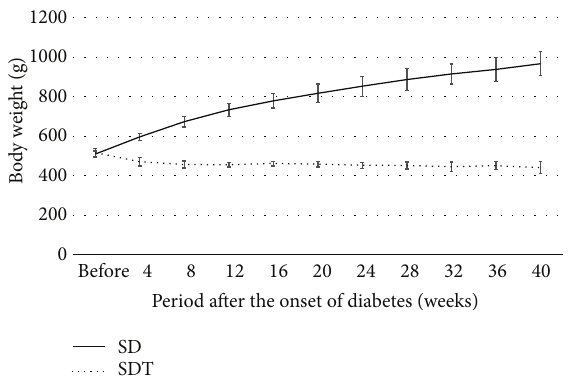
Figure 1: Body weight of the study animals. The SD rats are heavier than the SDT rats.